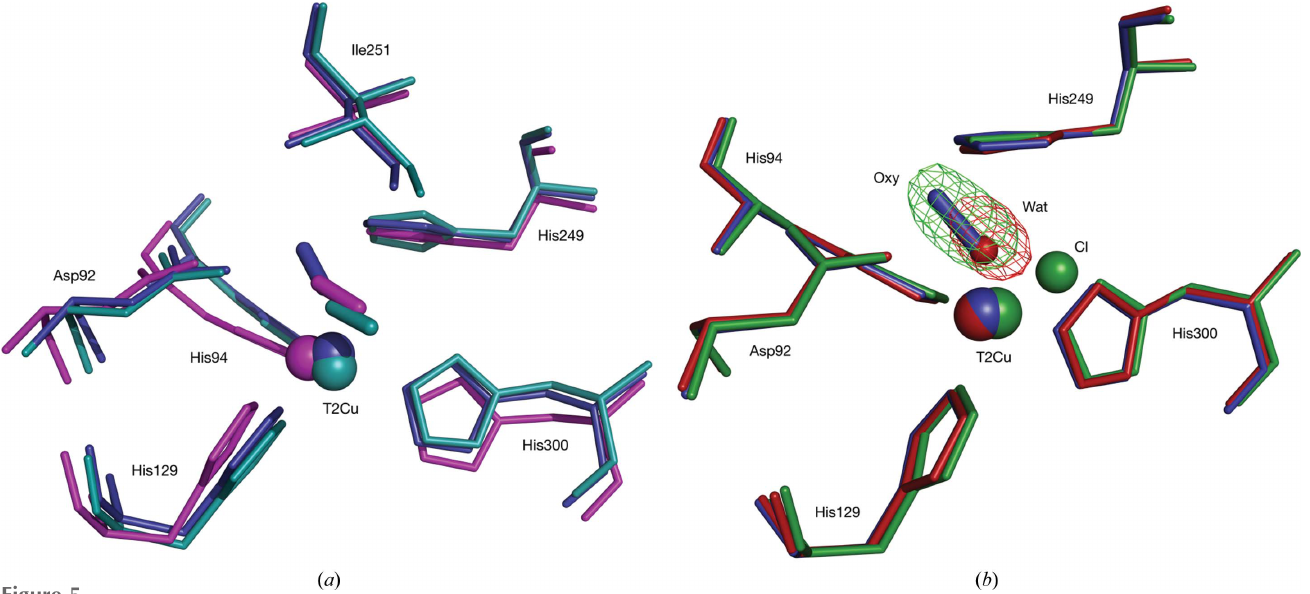
Figure 5 Ligand binding of T2Cu sites. ( a ) A comparison of the T2Cu ligand binding of NO by SRX (Horrell et al. , 2016), of O 2 by SRX (Fukuda et al. , 2015) and of O 2 by SF-ROX. The Ax NiR SF-ROX O 2 /superoxide is represented in blue, the Ac NiR SRX NO in teal and the Gt NiR SRX O 2 in magenta ( Ax NiR numbering). The teal NO and magenta O 2 ligands in the SRX models both occupy a similar binding mode apical to the T2Cu, while the blue O 2 ligating the SF-ROX structure is shifted significantly towards the two catalytic residues in an end-on mode. ( b ) A comparison of SRX Ax NiR, SF-ROX Ax NiR and SFX Af NiR resting-state T2Cu sites. The Ax NiR SRX structure is shown in red, the Ax NiR SF-ROX structure in blue and the Af NiR SFX structure in green (Fukuda et al. , 2016). The simulated-annealing F o (cid:3) F c OMIT electron-density maps are superimposed on the oxygen and water ligands contoured at 6 (cid:5) in green and red meshes, respectively. The SFX Af NiR resting-state T2Cu is bound by chloride ion from purification that is bound asymmetrically with respect to the His 3